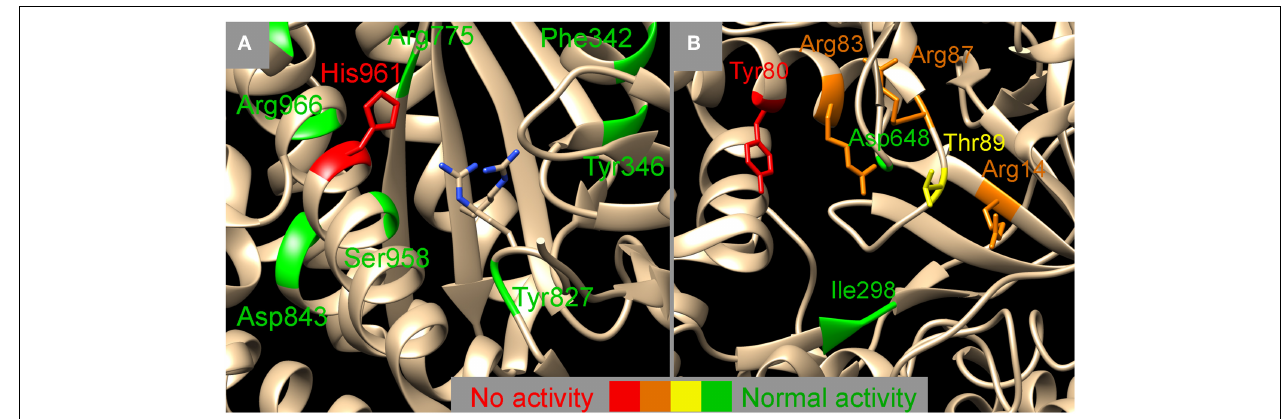
FIGURE 4 | Mapping the NisB mutants on two functional domains, the glutamylation domain (A) and the glutamate elimination domain (B) (PDB 4WD9, Ortega et al., 2015). Colors indicate the effect of the mutation on the dehydratase activity, red, no activity observed; orange, activity severely hampered; yellow, activity slightly hampered; green, normal activity. The exact nature of the mutation can be looked up in Table 1 . (A) Next to the